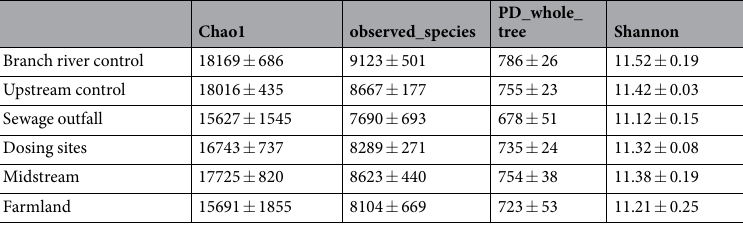
Table 1. Comparison of the estimated operational taxonomic unit (OUT) richness and diversity indices of the 16S rRNA gene libraries for clustering at 97% identity as obtained from the pyrosequencing analysis.